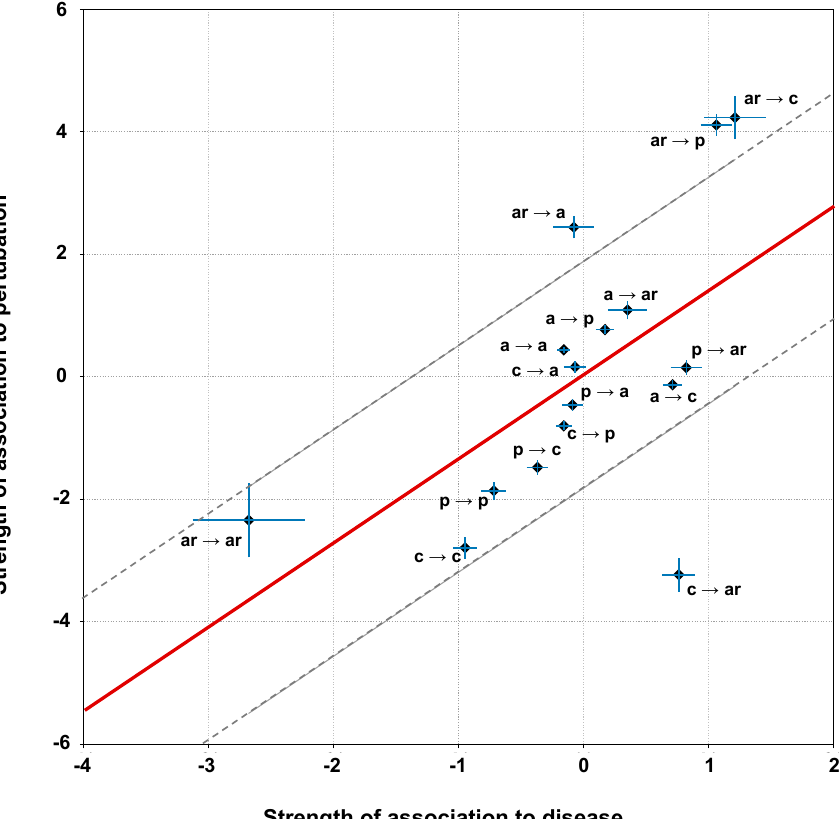
Figure 4. Correlation among strength of association of SRV types to diseases versus their strength of association to protein stability perturbation. Labels for variation types are as follows: p=polar, ar = aromatic, a = apolar and c = charged. Regression line is computed as described in Section 3.6. Error bars along both axes are computed as detailed in Section 3.5. Pearson’s correlation coefficient is equal 0.59 ( p -value equals 0.01).